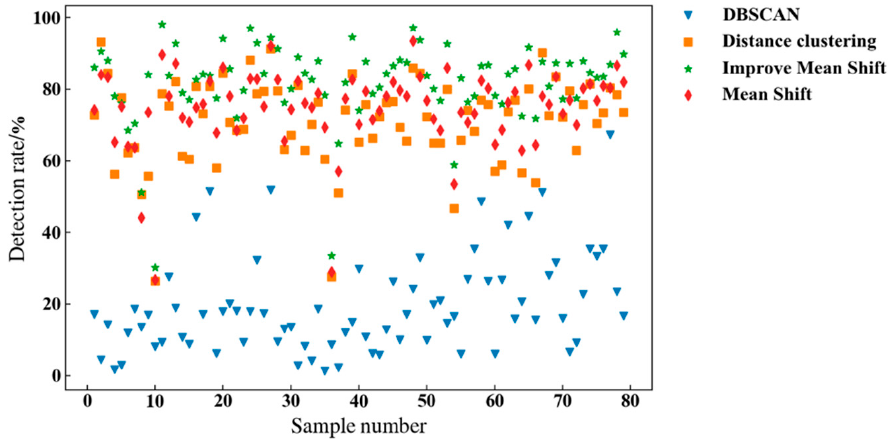
Figure 9. Detection ratio of oil tea fruit based on the YUV color space.